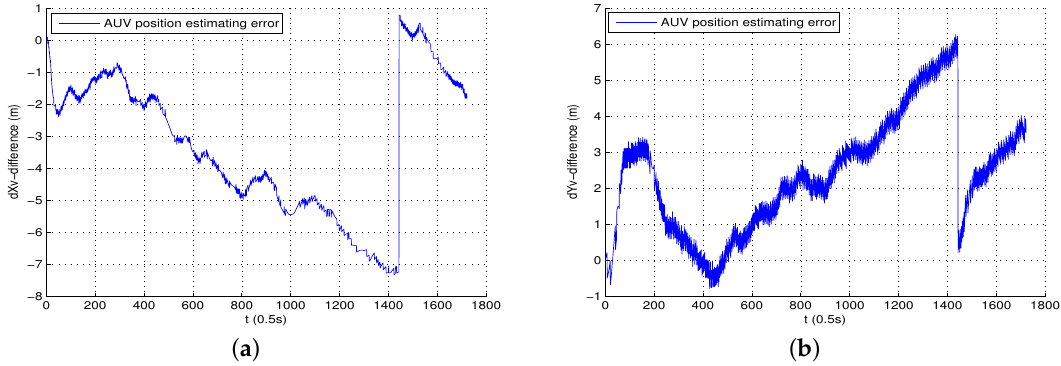
Figure 20. Deviation between estimated position and true position of AUV recorded by IMU in AUV homing to the M-DS are illustrated by that in ( a ) X direction and ( b ) Y